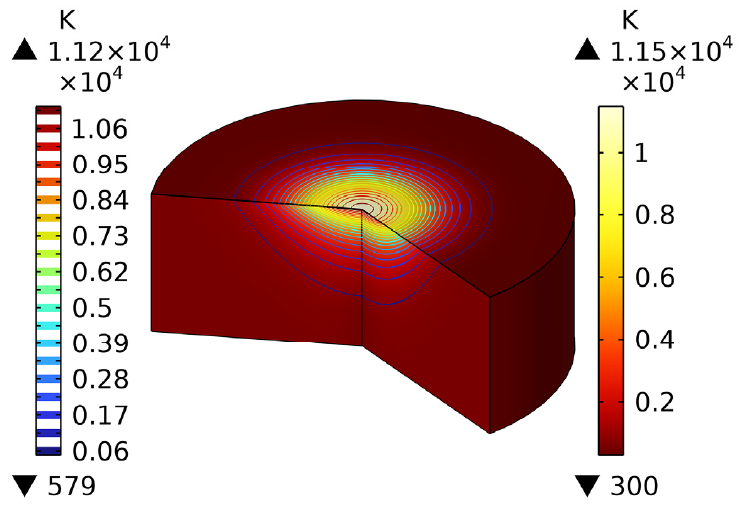
Figure 10. Simulation results of the temperature field distribution at an irradiation time of 1 ns.